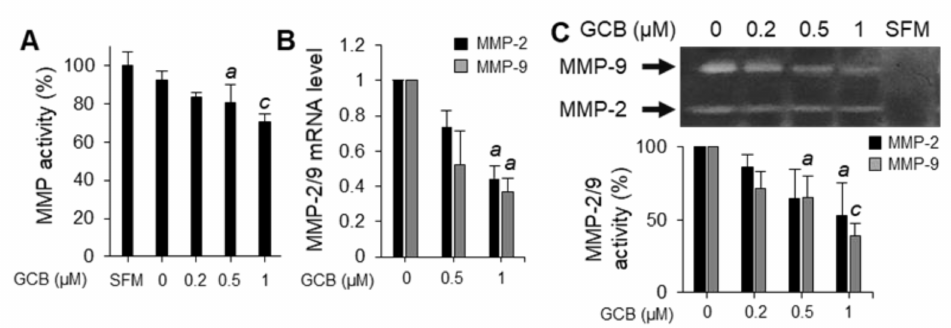
Figure 3. GCB inhibited MMP activity and transcription. ( A ) Gelatinase/collagenase assays were performed using secreted medium from GCB-treated Huh7 cells. Serum-free medium (SFM) was used as the negative control. The relative MMP activity was evaluated with the measured fluorescence value and is shown as a bar graph in comparison with the negative control (100%). Data were analyzed by one-way ANOVA; a p < 0.05 and c p < 0.001 relative to the negative control. ( B ) Huh7 cells were treated with GCB (0, 0.5, and 1 µ M) for 24 h, and the relative mRNA expression levels of MMP-2 and -9 were measured by qRT-PCR. The GAPDH gene was used as the reference gene for normalization. Values are expressed as the mean ± SEM (n = 3). Data were analyzed by one-way ANOVA; a p < 0.05 relative to the GCB-untreated control. ( C ) Huh7 cells were incubated with GCB (0, 0.2, 0.5, and 1 µ M) for 24 h in SFM. Samples were analyzed by zymography; SFM was used as the negative control. The data represent three experiments and are expressed as the mean ± SEM (n = 3). One-way ANOVA was used for analyzing the data; a p < 0.05 and c p < 0.001 relative to the GCB-untreated